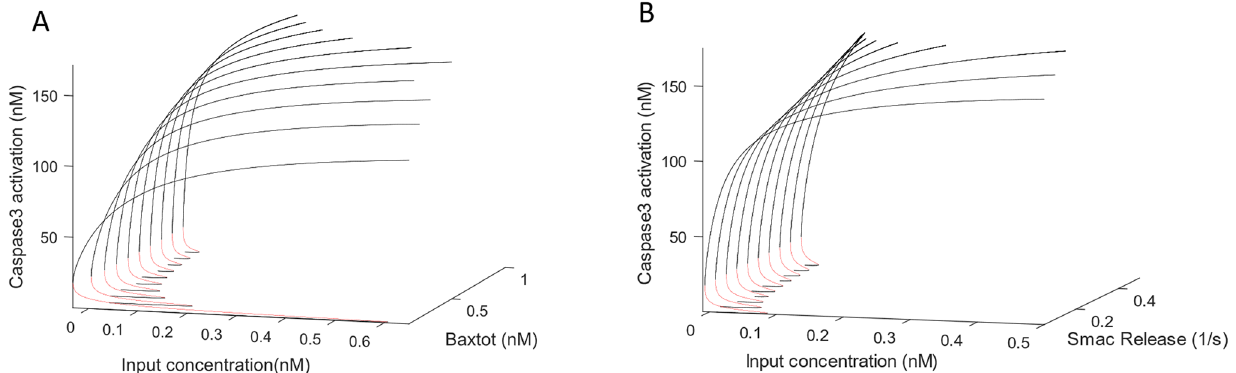
Figure 5. Impact of BAX and SMAC on the Activation Threshold of Caspase 3. ( A ). Bifurcation diagrams for a range of BAX initial concentrations (BAX0) (0.1–1 nM). Nominal BAX0 is 0.5 nM. The first limit bifurcation point of the nominal model with BAX0 at 0.5 nM occurs at u ( 0 .06 nM) , where the system transitions from the ‘off’ state to the ‘on’ state of caspase 3 activity in an all-or-none fashion. Upon decrease of BAX0, a higher limit bifurcation point is observed ( u ( 0 .6 nM) at BAX0 = 0.1 nM). Conversely, with increase in BAX0 to 0.8 nM, a decrease in threshold of caspase 3 activation is observed with a reduced bifurcation point of u (0.04 nM). SMAC remained as in the nominal model for all simulations with SMAC release rate = 0.1 s −1 . ( B ) Bifurcation diagrams for a range of SMAC release rate (0.05–0.5 s -1 ). Nominal SMAC release rate is 0.1 s −1 . The threshold for activation of C3* in the nominal model, with SMAC release rate (k19) = 0.1 is u (0.68 nM). With decrease in SMAC activation by decreasing k19 to 0.01, the threshold for activation of Caspase 3 decreases to u (0.9 8 nM) indicating the additional stimulus required to activate C3* upon decreased SMAC levels. With increase in SMAC activation (k19 = 0.1), a downward shift in activation threshold to u (0.02 nM) is activation of C3* and can explain how cell death could be triggered at a lower drug concentration in pathologies where BAX levels are increased. Importantly, this is biologically sound considering that an increase in BAX trans-